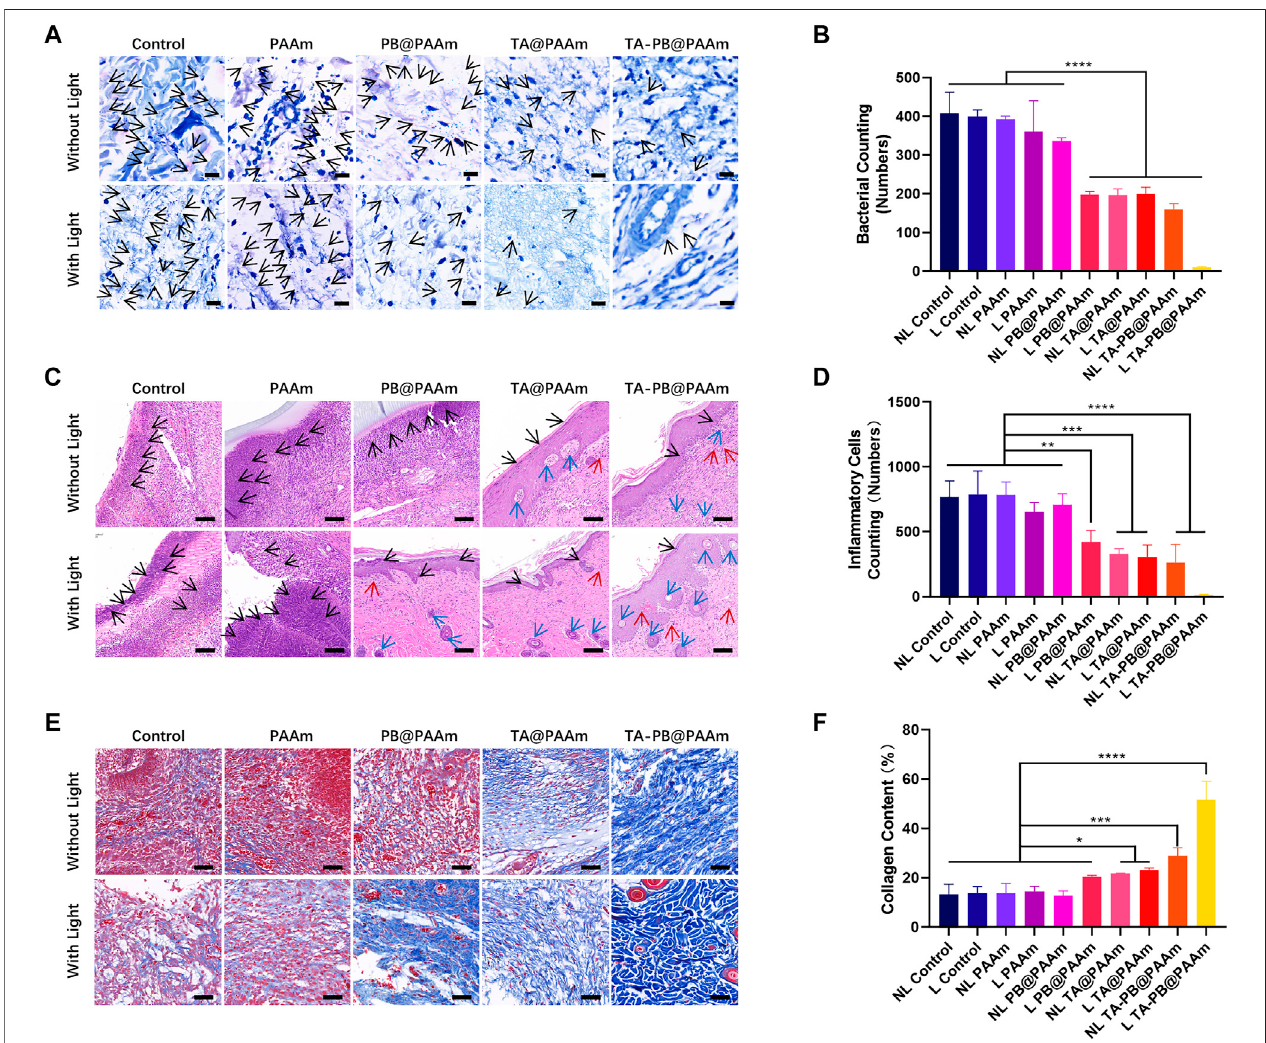
FIGURE 7 | Histological staining evaluation. (A) Giemsa staining of infective skin defects shows the smallest number of bacteria for the L TA-PB@PAAm group. Black arrow represents bacteria. Scale bar (cid:1) 20 μ m. (B) Quantitative results of bacterial viability in Giemsa staining. (C) H and E staining showed skin repair results,